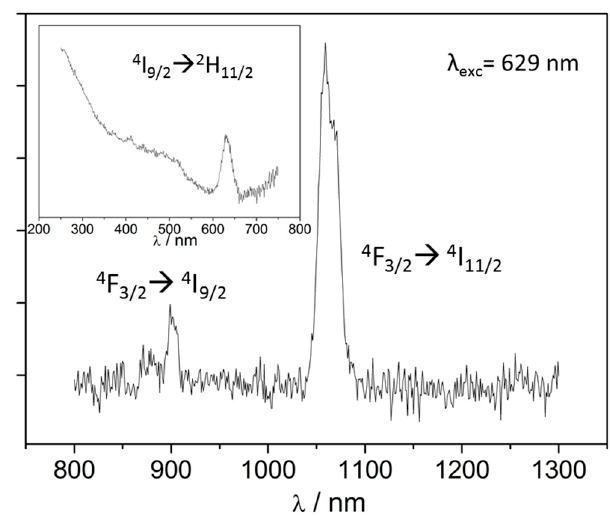
Figure 8. Emission spectrum of NdMurexAnhy measured at 77 K (excitation spectrum in inset).